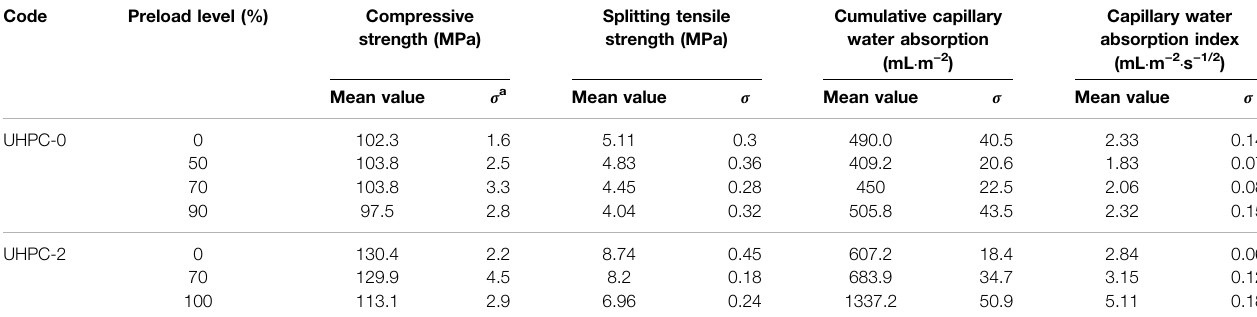
TABLE 2 | Mechanical and capillary water absorption properties of specimens after preloading.